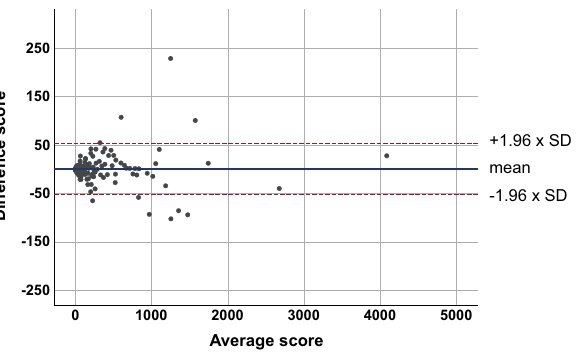
Figure 3. Bland–Altman plot between the standard and modified CAC scores from the validation set (n = 213).